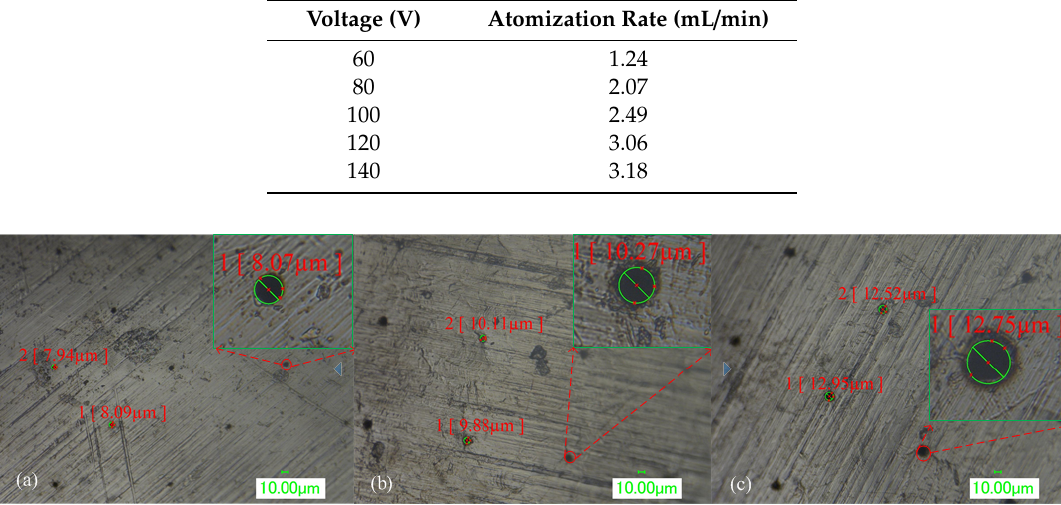
Table 4. Atomization rate of different micro-tapered aperture sizes.